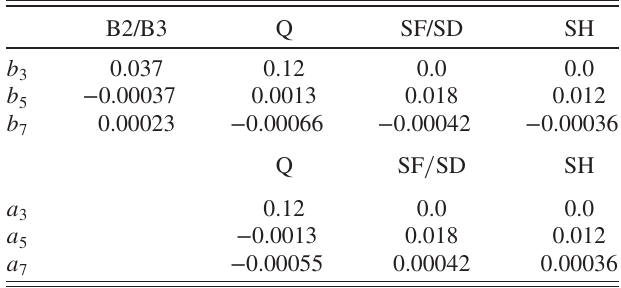
TABLE XII. Systematic higher-order multipole errors associ- ated with the dipole trim/corrector coils correcting in the horizontal (top) and vertical (bottom) planes. The correctors are embedded in the bending (B2/B3), quadrupole (Q), and sextupole (SF/SD/SH) magnets. Multipoles are in units of the corrector dipole field ( b 1 ¼ 1 and a 1 ¼ 1 for horizontal and vertical correctors).